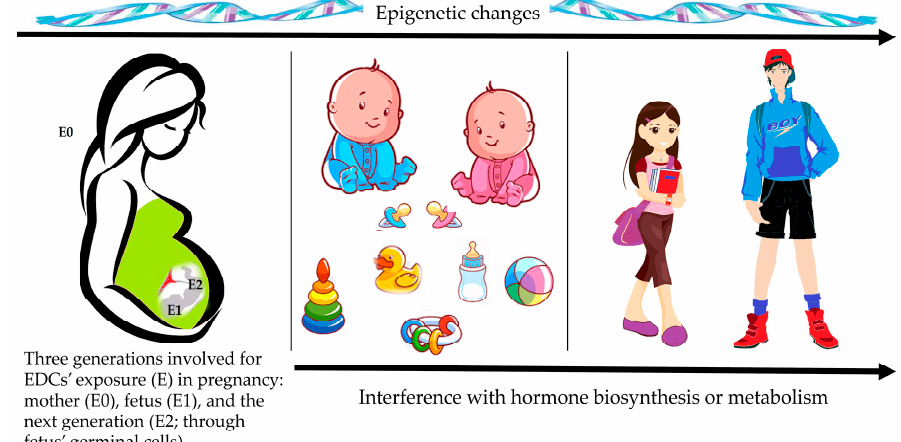
Figure 1. In utero, early postnatal life, and/or pubertal development are periods highly susceptible to EDCs’ exposure, leading to human health effects and susceptibility to a wide range of diseases and disorders through several mechanisms of action.